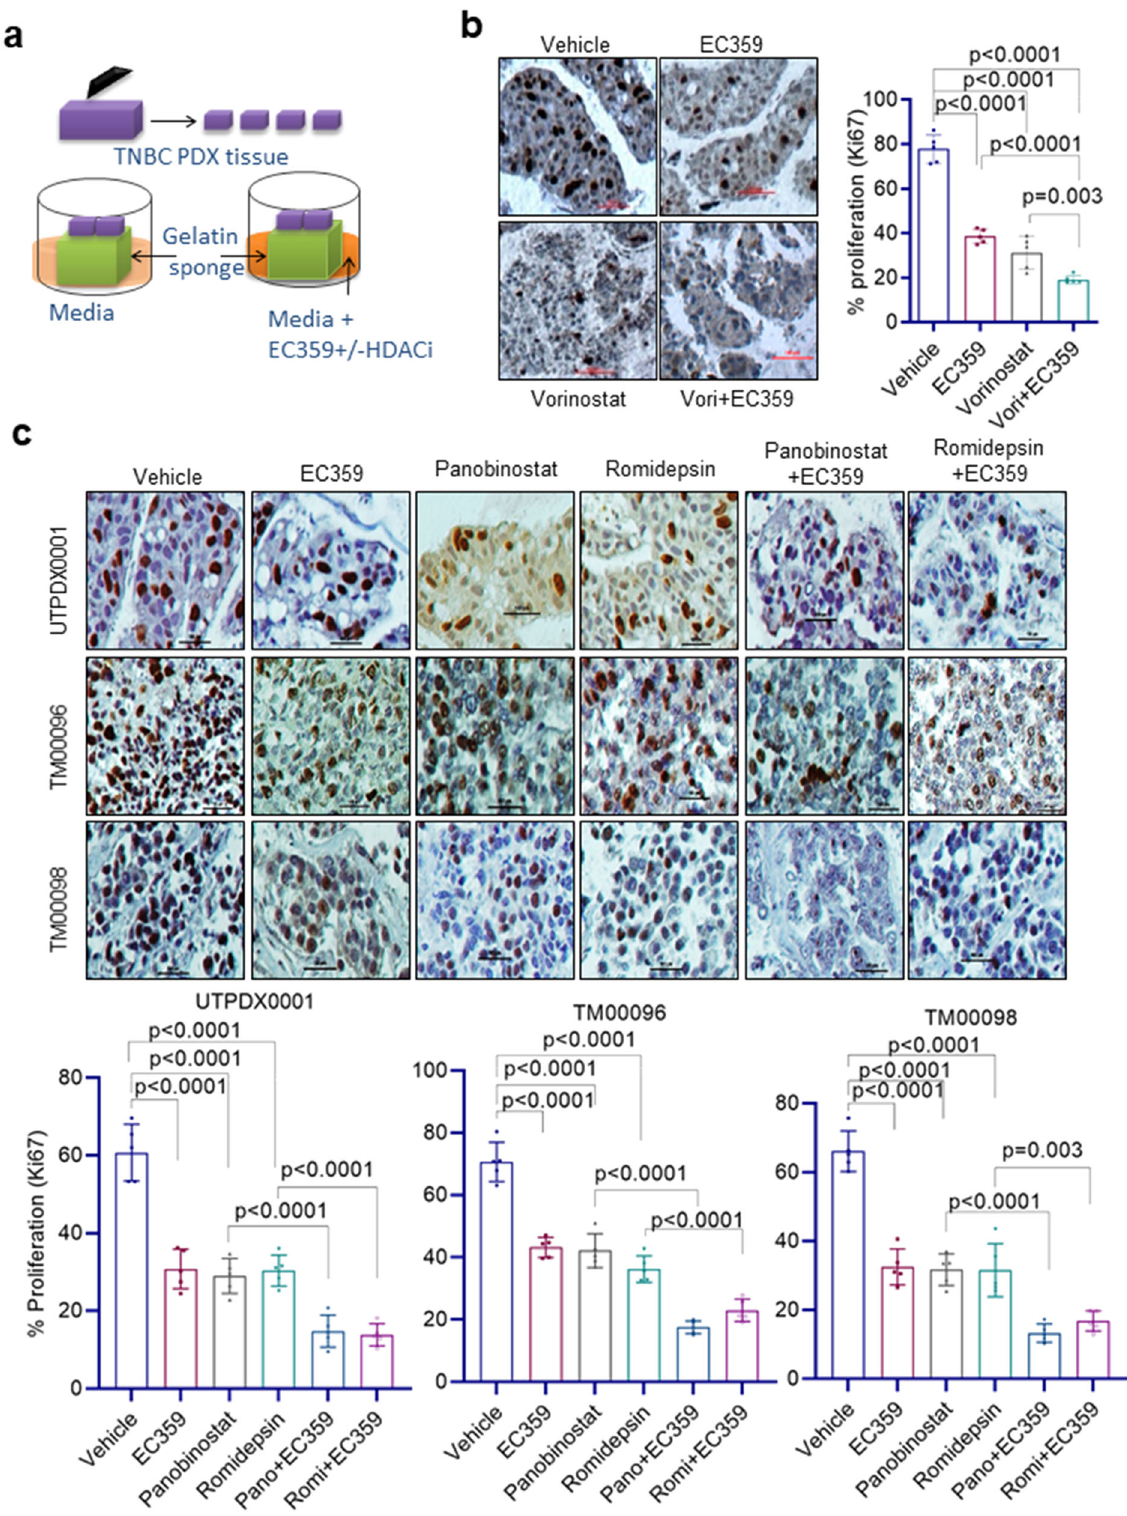
Fig. 6 EC359 enhance the ability of HDACi to decrease the proliferation of patient-derived xenograft explants (PDE) ex vivo. a Schematic representation of ex vivo culture model. b TNBC PDX explants (UTPDX0001) were treated with EC359 (500 nM), vorinostat (10 µ M), or combination for 72 h and the proliferation was determined using Ki67 immunostaining. Data are representative of three independent experiments ( n = 3). c TNBC explants from three different PDX tumors (UTPDX0001, TM00096; TM00098) were treated with EC359 (500 nM), panobinostat (100 nM), romidepsin (50 nM) or combination for 72 h and the proliferation was determined using Ki67 immunostaining. Representative Ki67 staining from each treatment condition is shown. Data are representative of three independent experiments ( n = 3). The number of Ki67-positive cells from fi ve different images were counted and plotted as histogram. Error bars represent SD. In b , and c , p -values were calculated using one-way ANOVA.